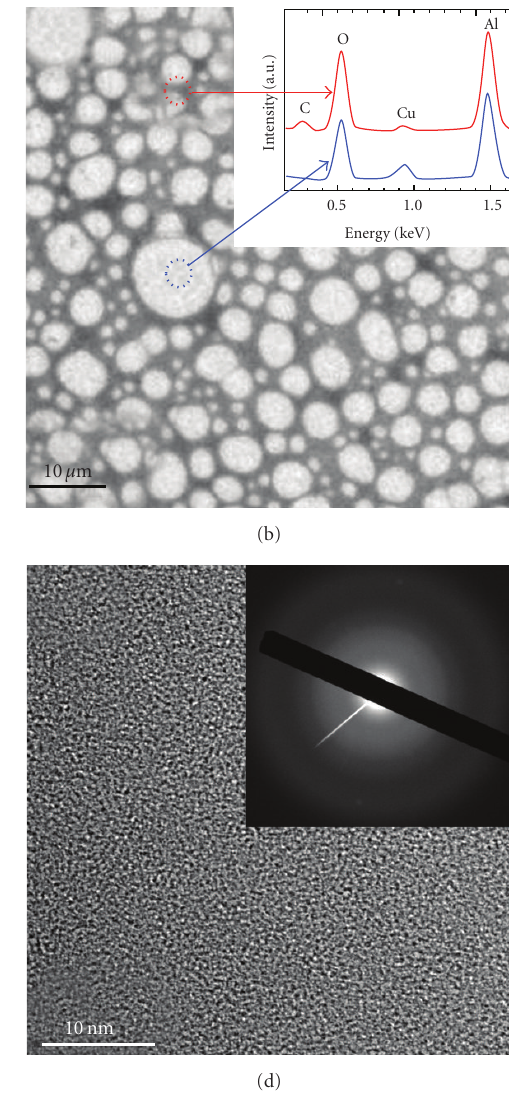
Figure 1: TEM images of ALD Al 2 O 3 films with thickness of 2nm at (a) low magnification, (b) medium magnification, (c) high magnification, and (d) HRTEM. Inset in (a) illustrates the layer-structure of a coated TEM grid with part of the Al 2 O 3 film and holey carbon film raised for viewing purpose. Inset in (b) is EDS of the ALD film. The top spectrum comes from the holey carbon region while the bottom one from the thin Al 2 O 3 film region. Inset in (d) is SAED of the Al 2 O 3